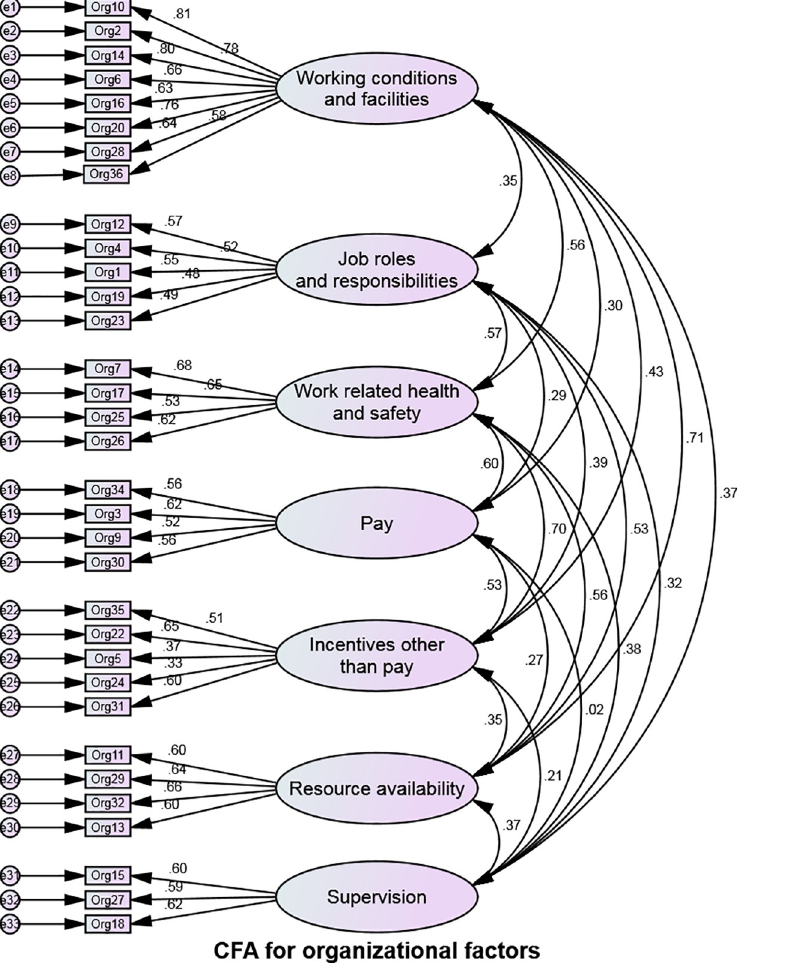
Fig 3. Confirmatory Factor Analysis (CFA) for organizational